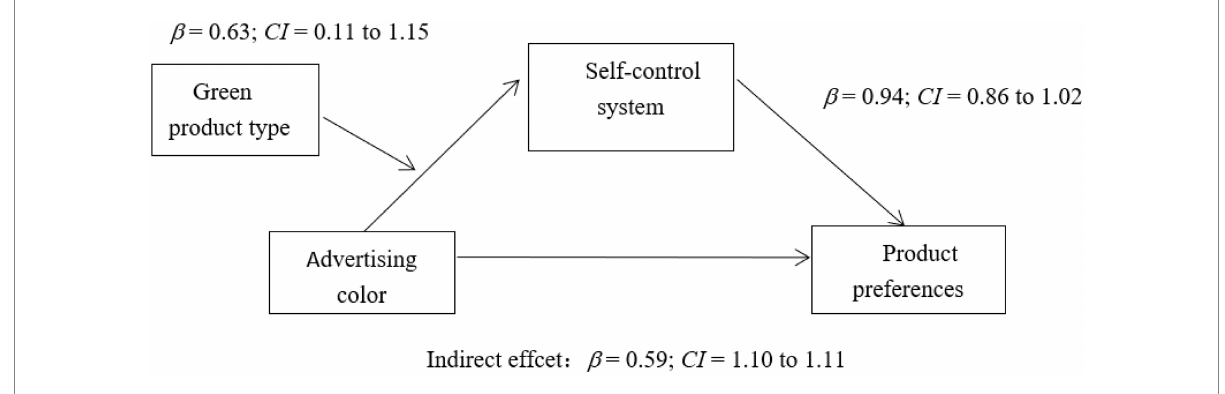
FIGURE 3 The Moderating Role of Green Product